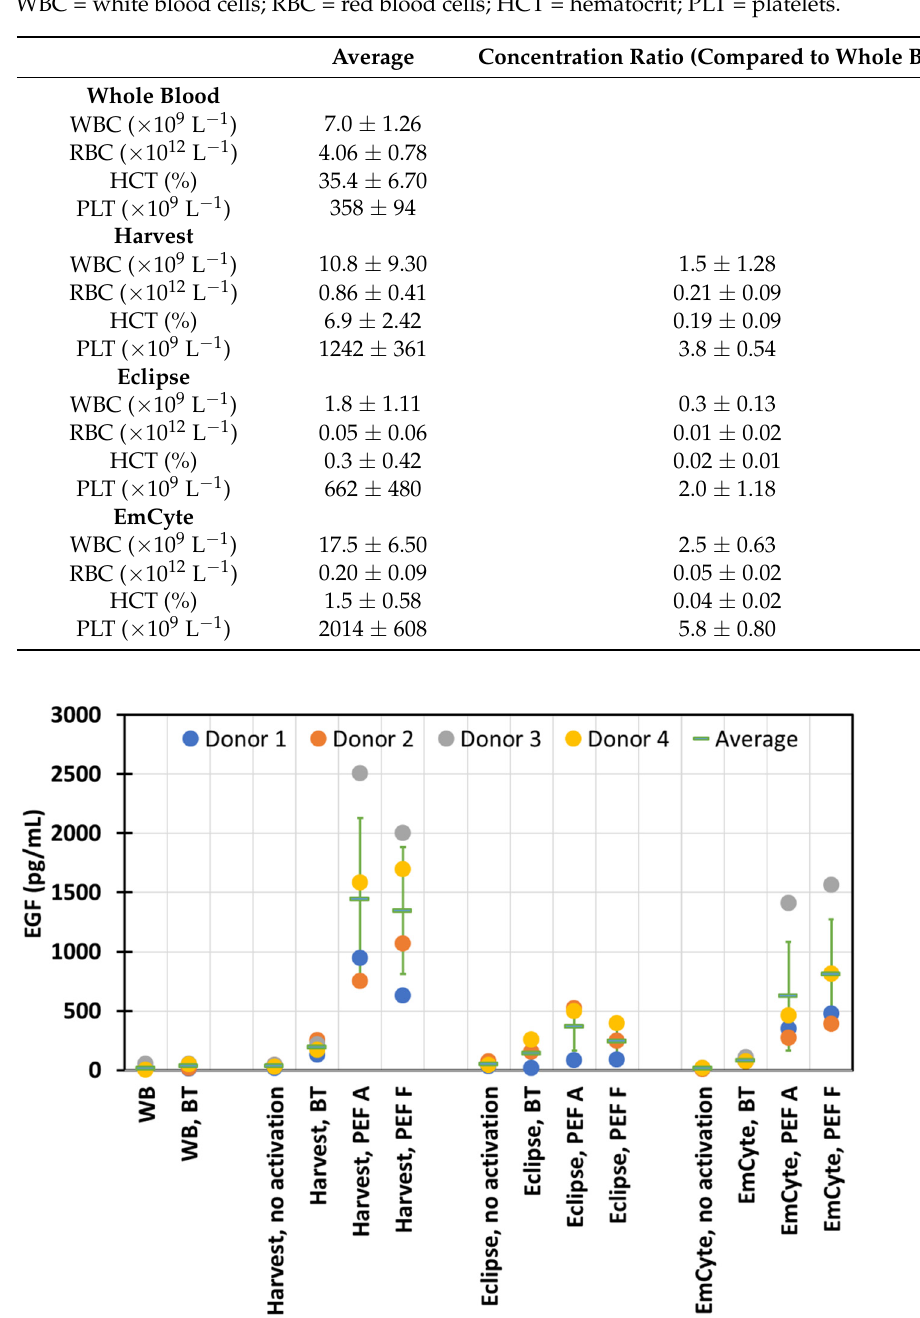
Figure 2. EGF release for: whole blood (WB)—no activation and bovine thrombin (BT) activation; Harvest PRP (no activation, bovine thrombin—BT-activation, and activation using electric stimulation with pulses A and F); Eclipse PRP (no activation, bovine thrombin—BT-activation, and activation using electric stimulation with pulses A and F); EmCyte PRP (no activation, bovine thrombin—BT-activation, and activation using electric stimulation with pulses A and F). Note that there is no Donor 3 data for Eclipse.